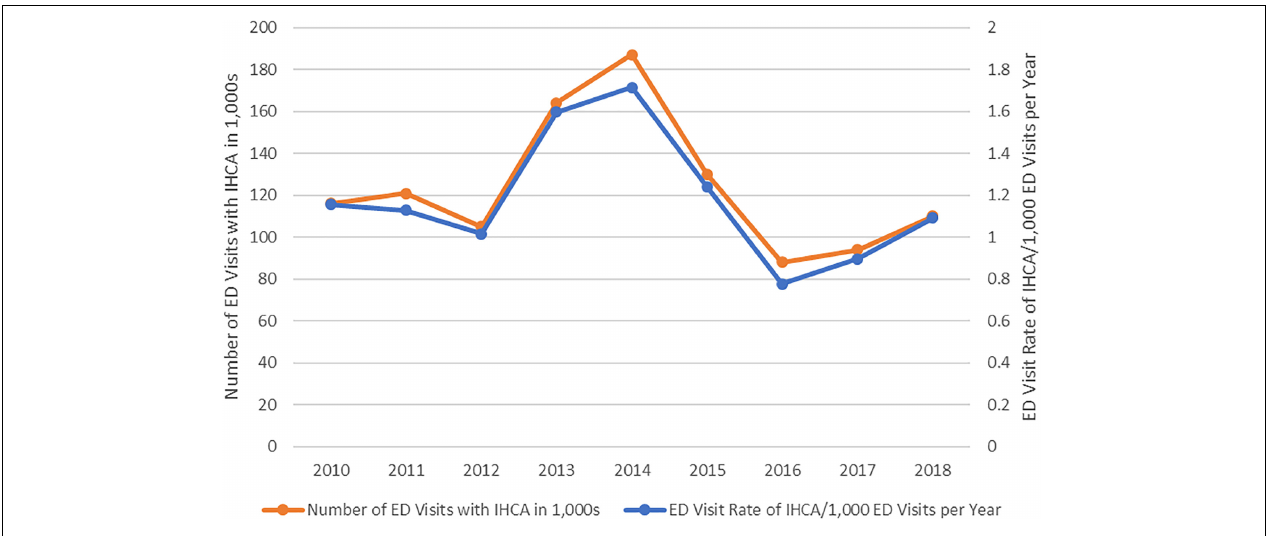
FIGURE 2 | The number and incidence (visit) rate of emergency department-based in-hospital cardiac arrest, 2010–2018.